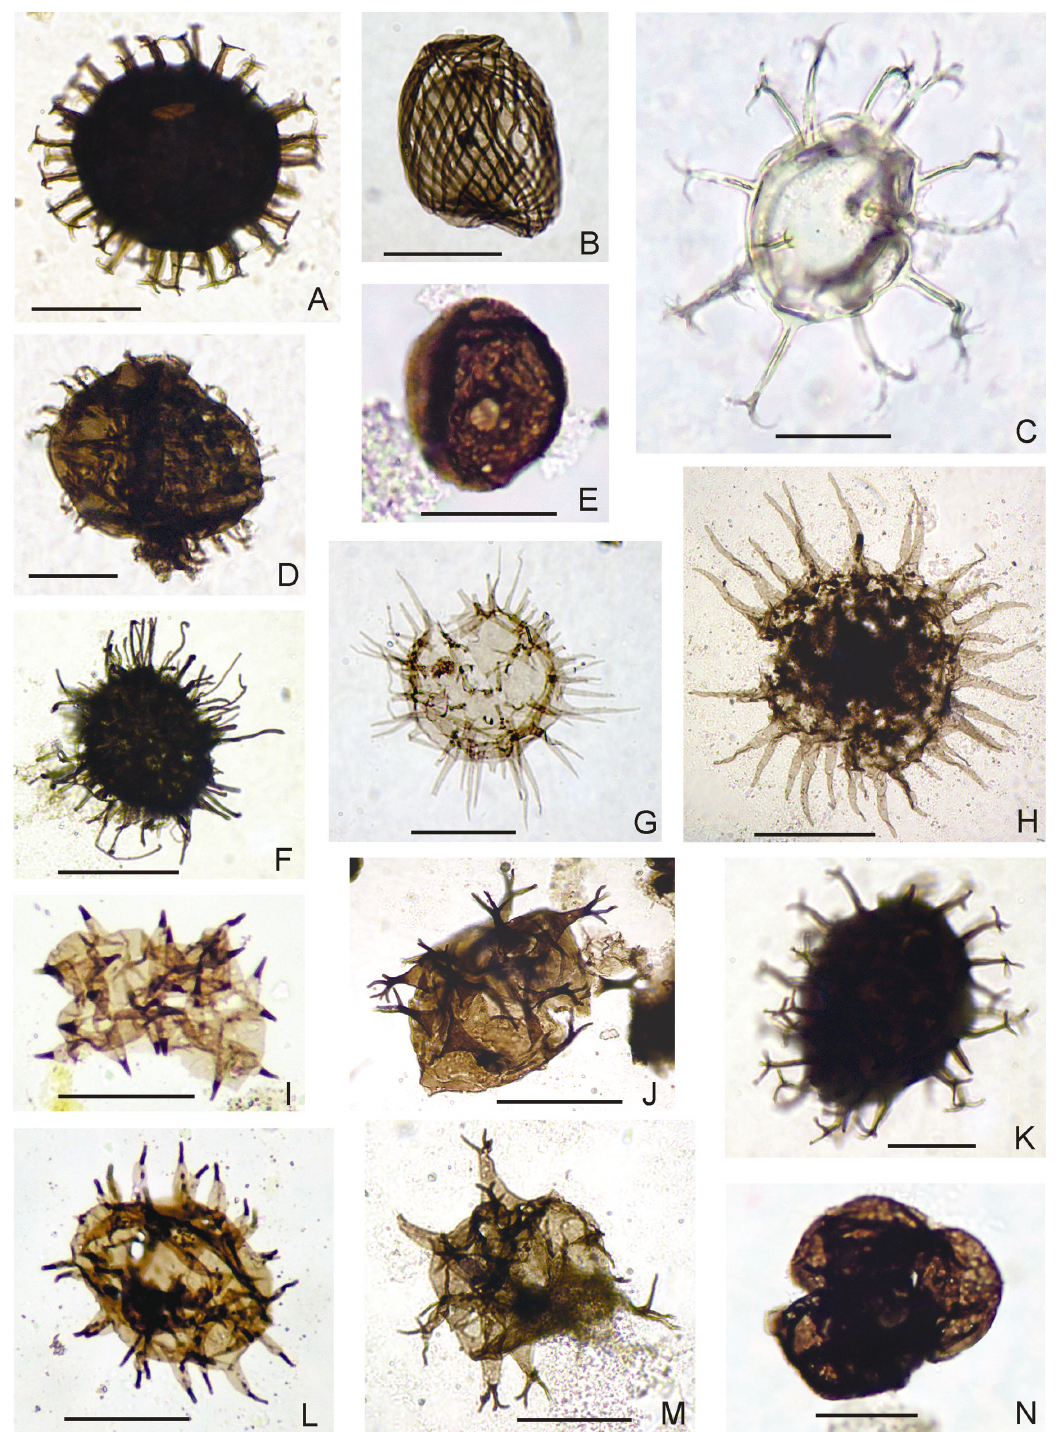
Fig. 2. Acritarchs from the Upper Ordovician of the Bol ′ shaya Nirunda River, Siberian Platform. A , Peteinosphaeridium armatum Tongiorgi, Yin Lei-ming & Di Milia, 1995, II-2, D46/2. B , Dactylofusa ( Moyeria ) cabottii (Cramer, 1971) Fensome, Williams, Barss, Freeman & Hill, 1990, II-2, L30/3. C , Oppilatala sp. II-36, V22/3. D , Sacculidium aff. S. macropylum (Eisenack, 1959) Ribecai, Raevskaya & Tongiorgi, 2002, I-5, M26/4. E , Dicommopalla macadamii Loeblich, 1970, II-17, R26/3. F , Gorgonisphaeridium sp. 1. I-11/1, Q41/4. G , Gyalorhethium sp. IV-7, C23/1. H , Gyalorhethium sp., I-3, W36/2. I , Gen. indet. A, sp. 1. II-2, B36/2. J , M , Gen. indet. B, sp. 1. II-8/2, 10-V37; 13-Q46. K , Peteinosphaeridium sp., II-8/1, S34/4. L , Gen. indet. A, sp. 2. II-2, Q34/2. N , Cryptospore, II-5, P34/4. Scale bare represents 30 (cid:181)